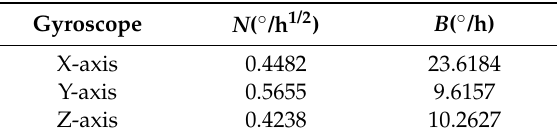
Table 2. Results of Gyroscope Allan Variance.